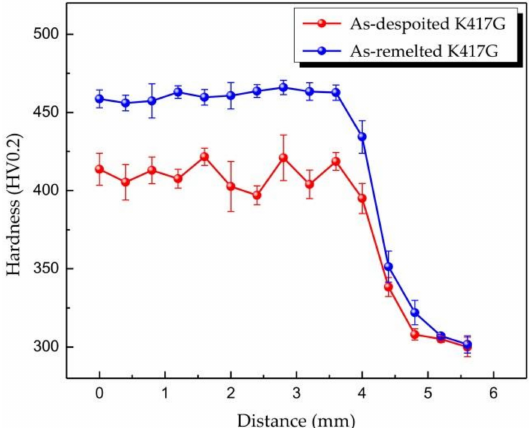
Figure 17. Microhardness of the LFRed K417G before and after laser